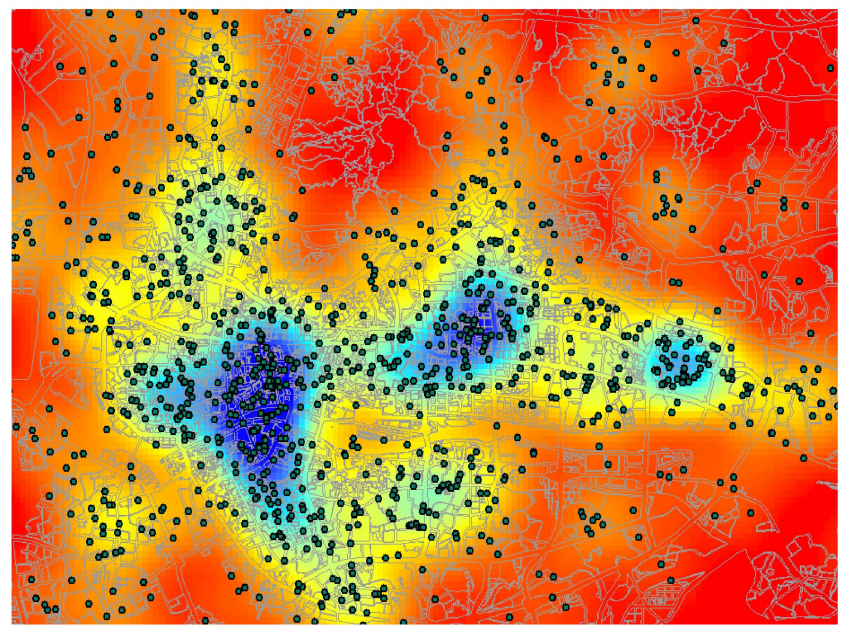
Figure 6. Diagram of kernel density estimation for POI data. (The figure was drawn by the